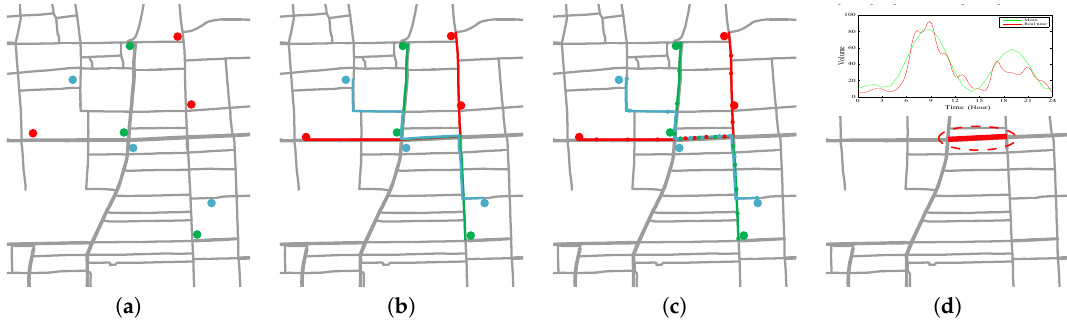
Figure 1. Road Anomaly Detection. ( a ) GPS Snippets; ( b ) Full Paths; ( c ) Trajectories; ( d ) Anomaly